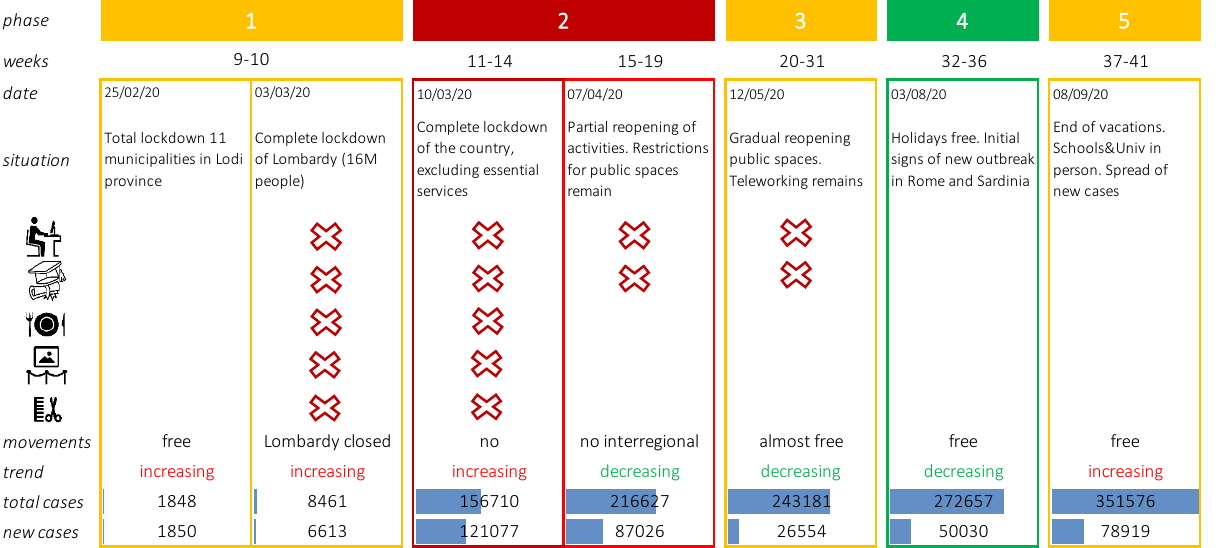
Figure 1. Timeline of the COVID-19 outbreak in Italy and the government policies. Source: our elaborations. Icons from